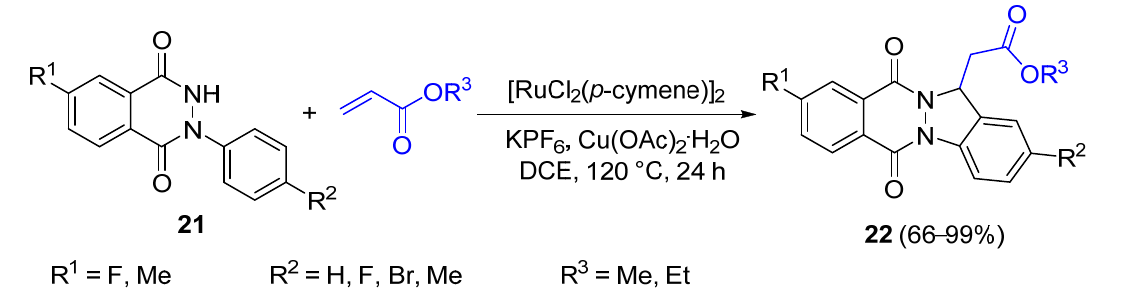
Scheme 8. Synthesis of indazolo[1,2- a ]indazolone